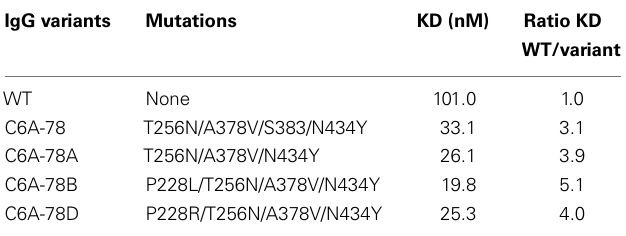
Table 3 | Comparison of Fc variants generated by directed mutagenesis to increase FcRn binding .